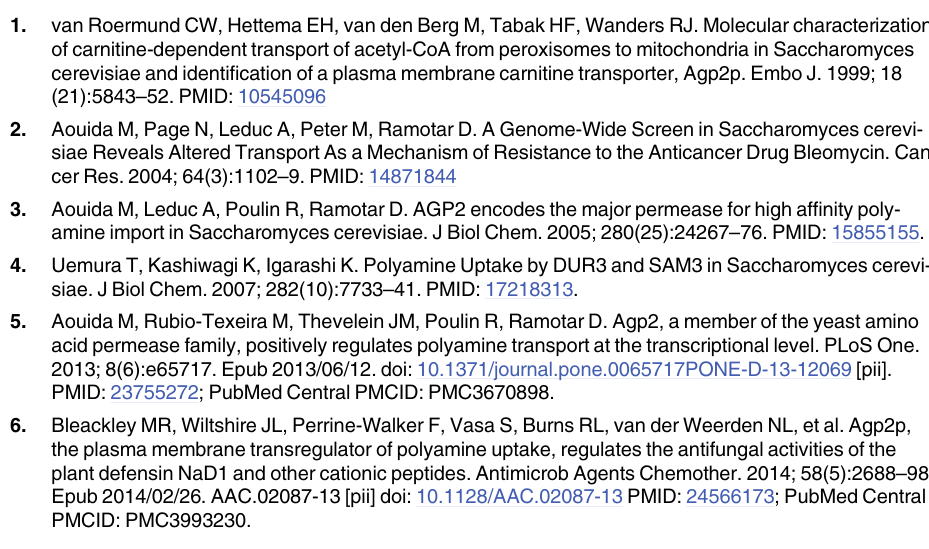
S1 Fig. Doxorubicin compromises DAPI staining. Cells were grown in YPD media and uptake was carried out for 30 min with 800 μ M DOX in either the same media or transfer to low YNB. Cells without DOX or after uptake were staining with DAPI before microscopy. In all experiments, DOX uptake severely compromised staining of the nuclear DNA with DAPI, which is likely due to the binding of DOX onto the DNA prevents DAPI binding. S2 Fig. Comparison of the similarities and differences amongst three organic cation trans- porters, S. cerevisiae Sam3, C. elegans OCT-1 and human OCT1. The predicted amino acid sequences for the transporters were obtained from NCBI and aligned using CLUSTAWL. The residues shown in red are present in the CeOCT-1a isoform, identities of 3 or more amino acid residues are highlighted in cyan, and yellow indicates distinct differences between CeOCT-1 and human OCT1. Asterisks indicate identical amino acid